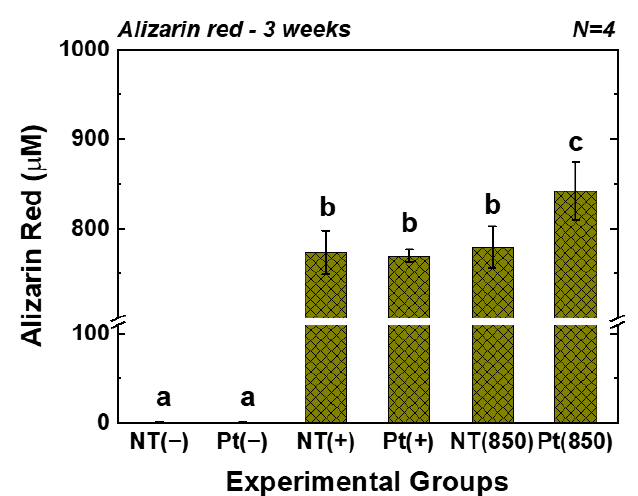
Figure 6. AR values of TiO 2 NT and Pt-TiO 2 NT after three weeks of incubation (In each graph, the experimental groups with different letters indicate statistical significance by one-way ANOVA at α = 0.05).